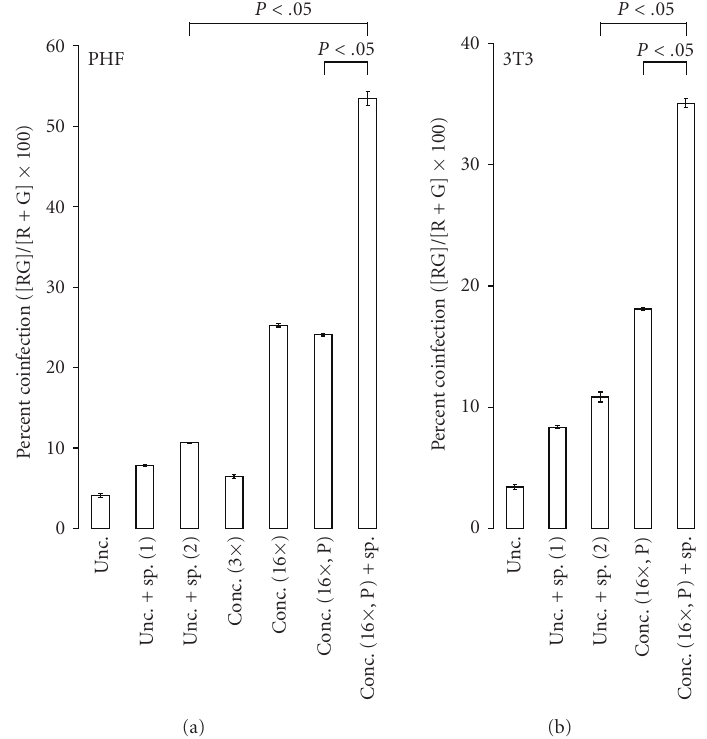
Figure 3: Coinfection with two retroviral vectors as a function of treatment. Coinfection rates were calculated as cells that are both green and red as a percentage of cells that are either green or red. (a) Mixed green and red vectors (1 : 1) were added to PHF (CRL-2703) in unconcentrated ( unc. ) form; with spinoculation ( sp. ; 1200 g, 15 ◦ C, 2 hours; (1) = with replacement of 50% of viral supernatant after 4 hours; (2) = complete change of medium after 4 hours); with concentration ( conc. ) from 3 sets of Plat-A plates or 16 sets, using 10,000 g for 3 hours; concentrated using Polybrene flocculation (P); or combined concentration with Polybrene and spinoculation. (b) Mixed green and red vectors (1 : 1) were added to 3T3 cells in unconcentrated ( unc. ) form; with spinoculation ( sp. ; 1200 g, 15 ◦ C, 2 hours; (1) = with replacement of 50% of virus after 4 hours; (2) = change of medium after 4 hours); concentrated using Polybrene flocculation (P); or combined concentration with Polybrene and spinoculation. For both CRL-2703 and 3T3, coinfection rates were calculated 4 days after infection. Averages from three experiments are shown ± standard deviation. Significant di ff erences ( P < . 05) are indicated for the combination of spinoculation and Polybrene flocculation versus either procedure